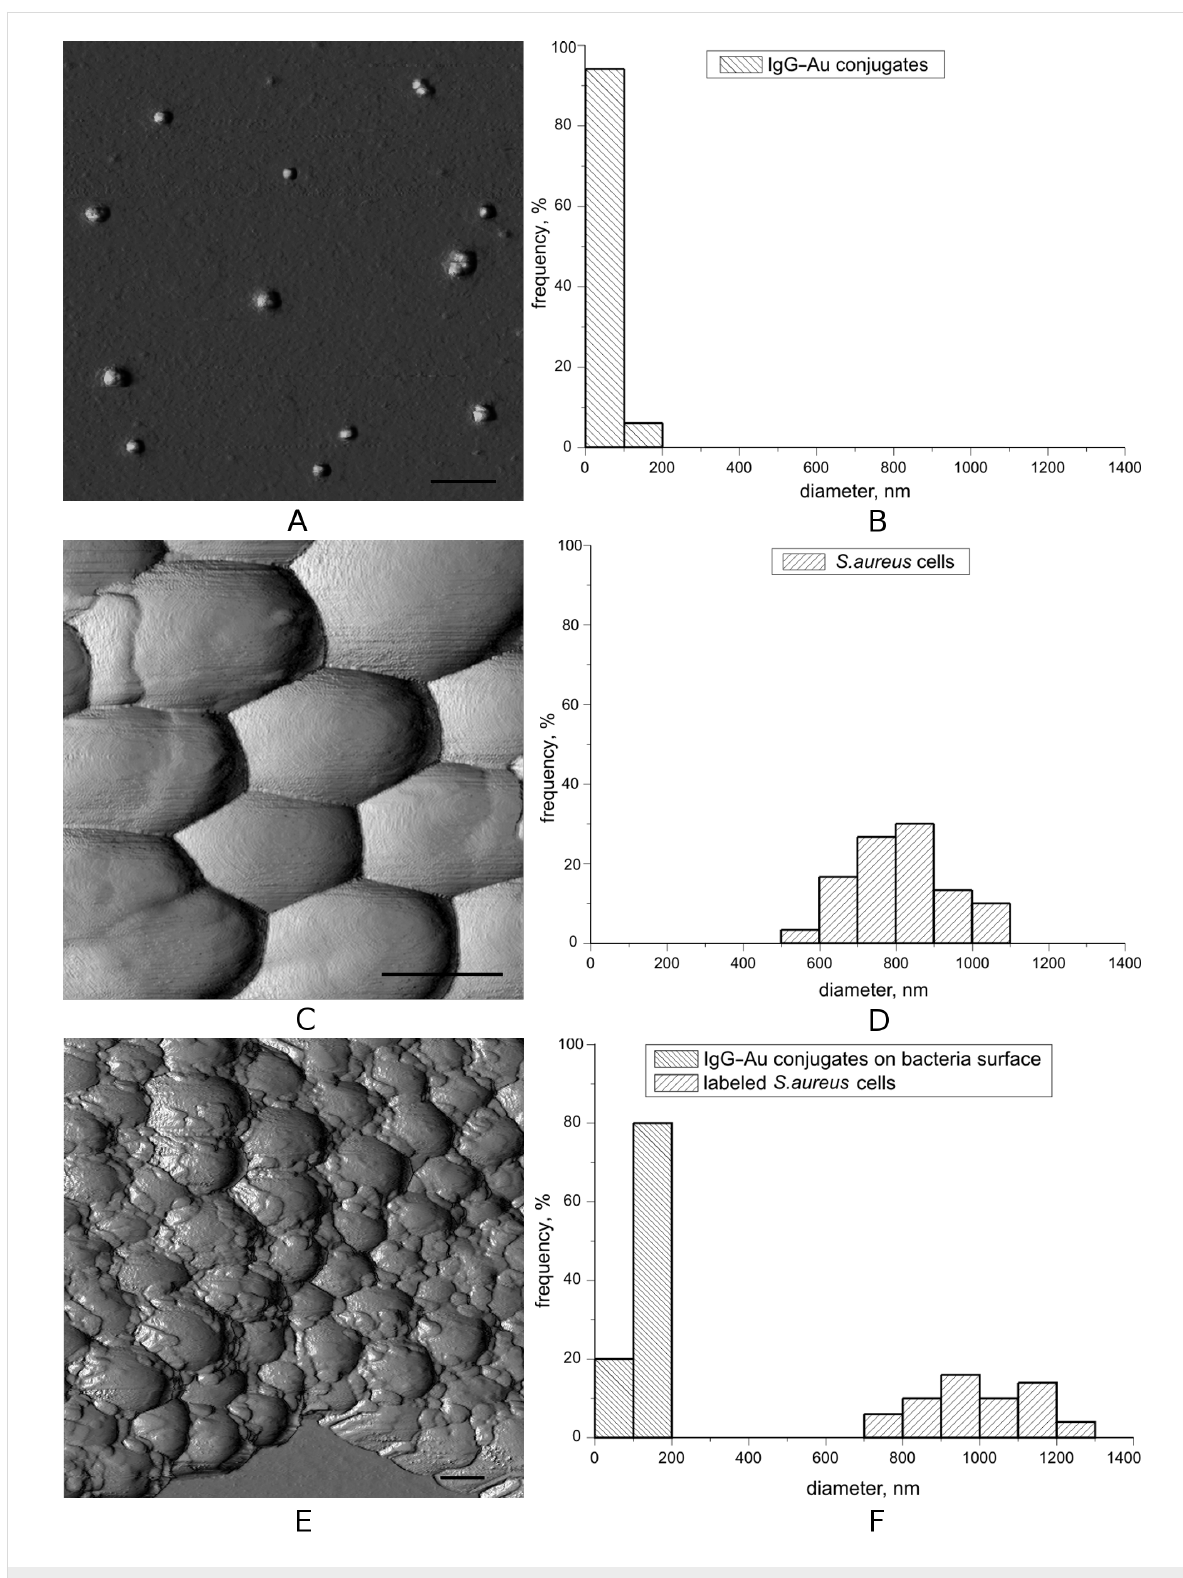
Figure 1: Topographic AFM images of the IgG–Au conjugates (a), S. aureus cells before (c) and after (e) contact with conjugates. Scale bar is 500 nm in all panels. (b), (d), (f) - Size (diameter) distribution histograms of corresponding structures. Information for each histogram was collected from several